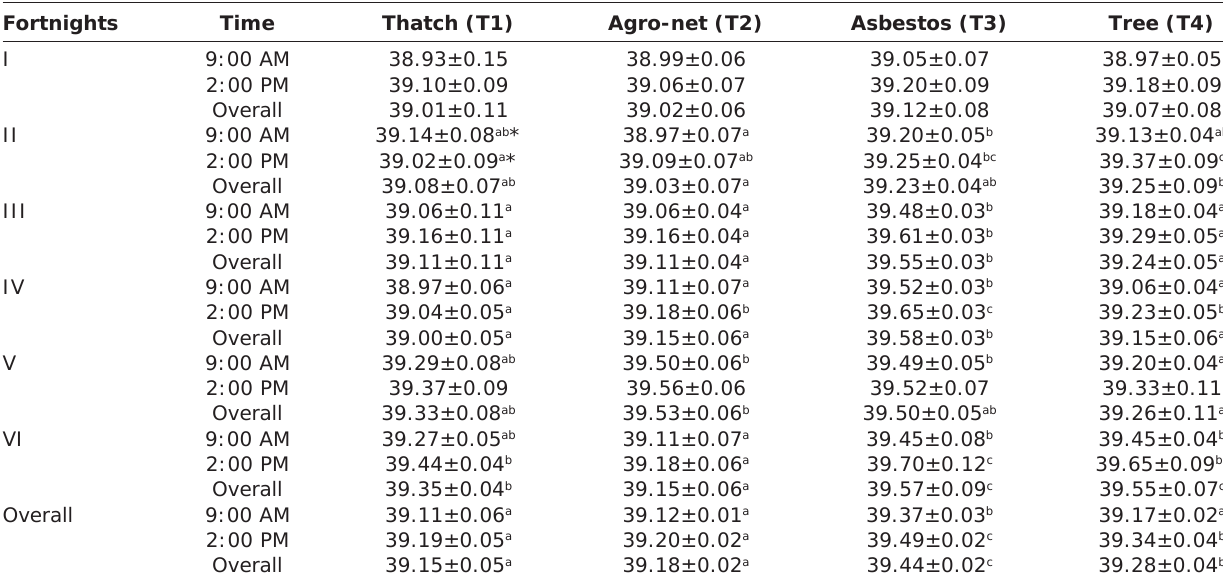
Table-2: Mean±SEM of rectal temperature (°C). Fortnights